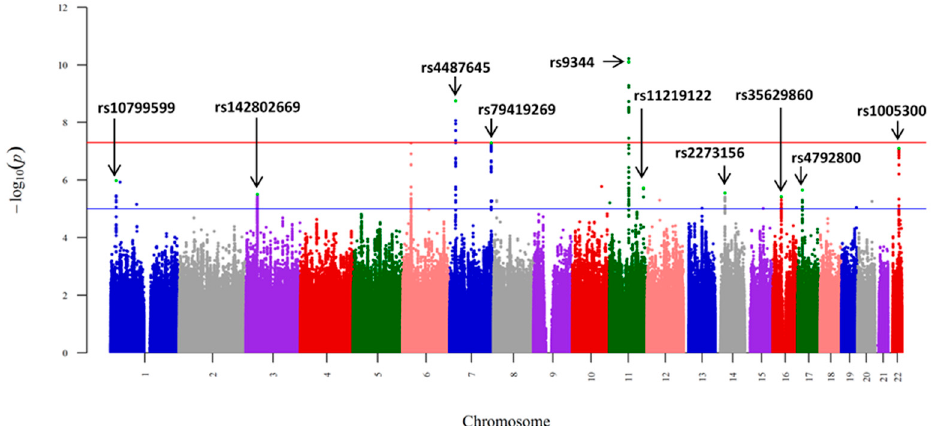
Figure 2. Manhattan plot on meta-analysis of the 1230 AL-amyloidosis cases and 7589 regionally matched controls. SNP IDs (rs numbers) are shown for 10 SNPs, in peaks with p -value below 10 − 5 . The x-axis shows the chromosomal position and the y-axis is the significance (–log 10 p ; 2-tailed) of association derived by logistic regression. The red horizontal line represents the genome-wide significance thresholds of p = 5.0 × 10 − 8 and the blue horizontal line represents the suggestive signifi- cance thresholds of p = 1.0 × 10 − 5 . From reference [22] with permission. Table 1. Association of SNP rs9344 with AL ( N = 380) overall and by cytogenetic subtype (refer- ence [22]).